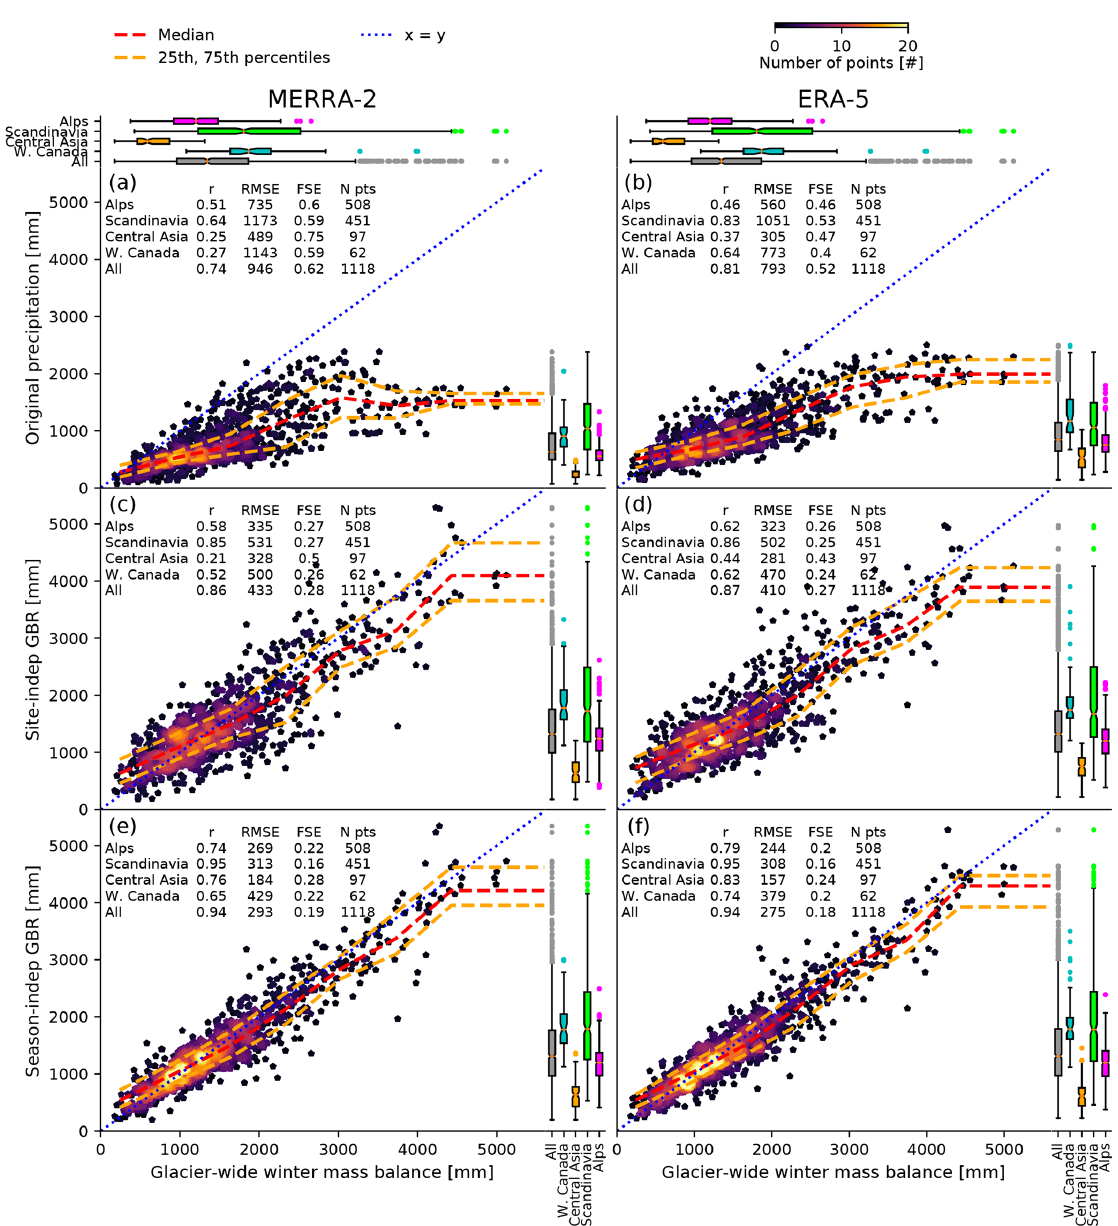
Figure 3. Comparison between all glacier-wide B w values and the model estimates: (a) original MERRA-2, (b) original ERA5, (c) MERRA- 2 site-independent GBR, (d) ERA5 site-independent GBR, (e) MERRA-2 season-independent GBR and (f) ERA5 season-independent GBR. The Pearson correlation (CORR), the root mean square error (RMSE), the fraction of standard error (FSE, corresponding to the RMSE divided by the regional mean B w ) and the number of all seasons of all glaciers ( N points) for each region are also reported. The boxplots indicate the distribution of the model’s estimates (right) and of the B w data (top) for each